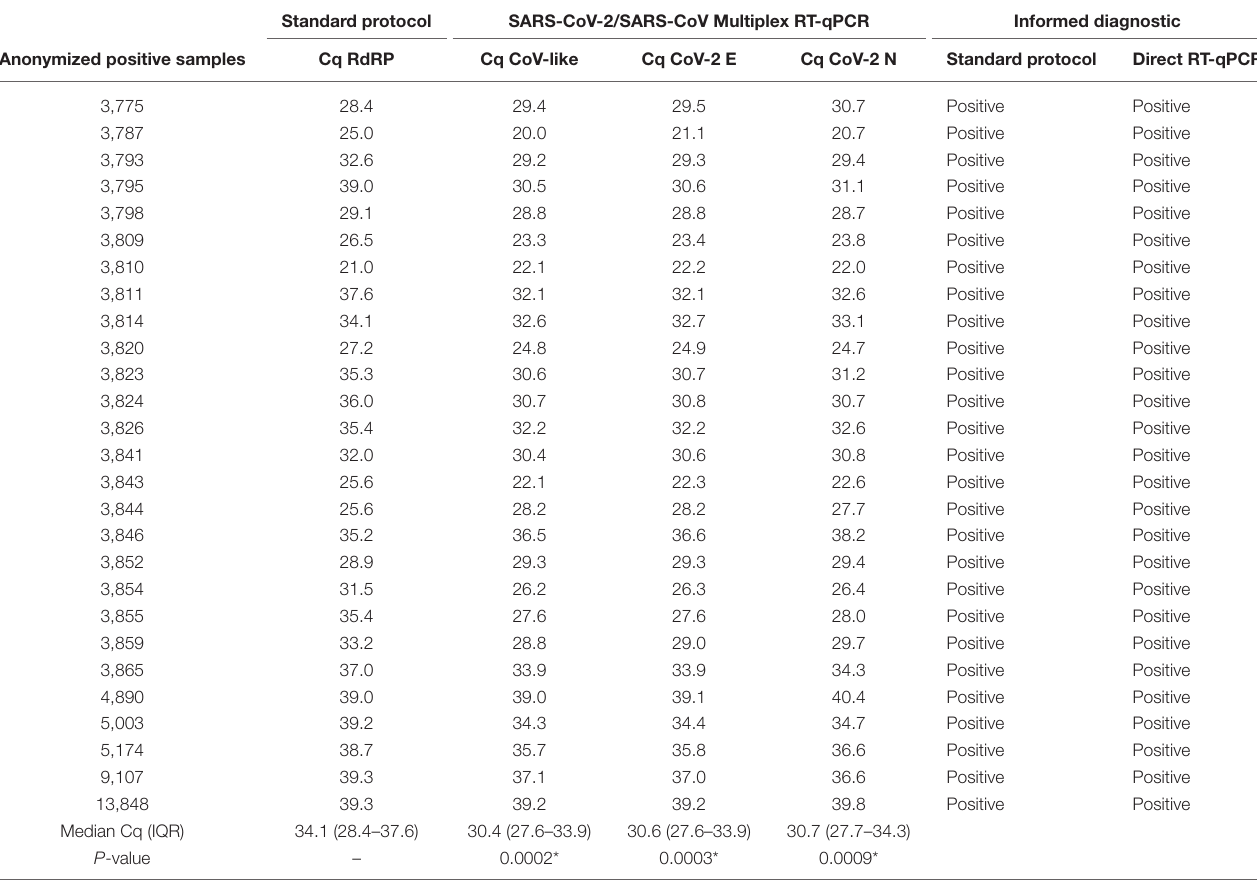
TABLE 3 | Validation of the direct